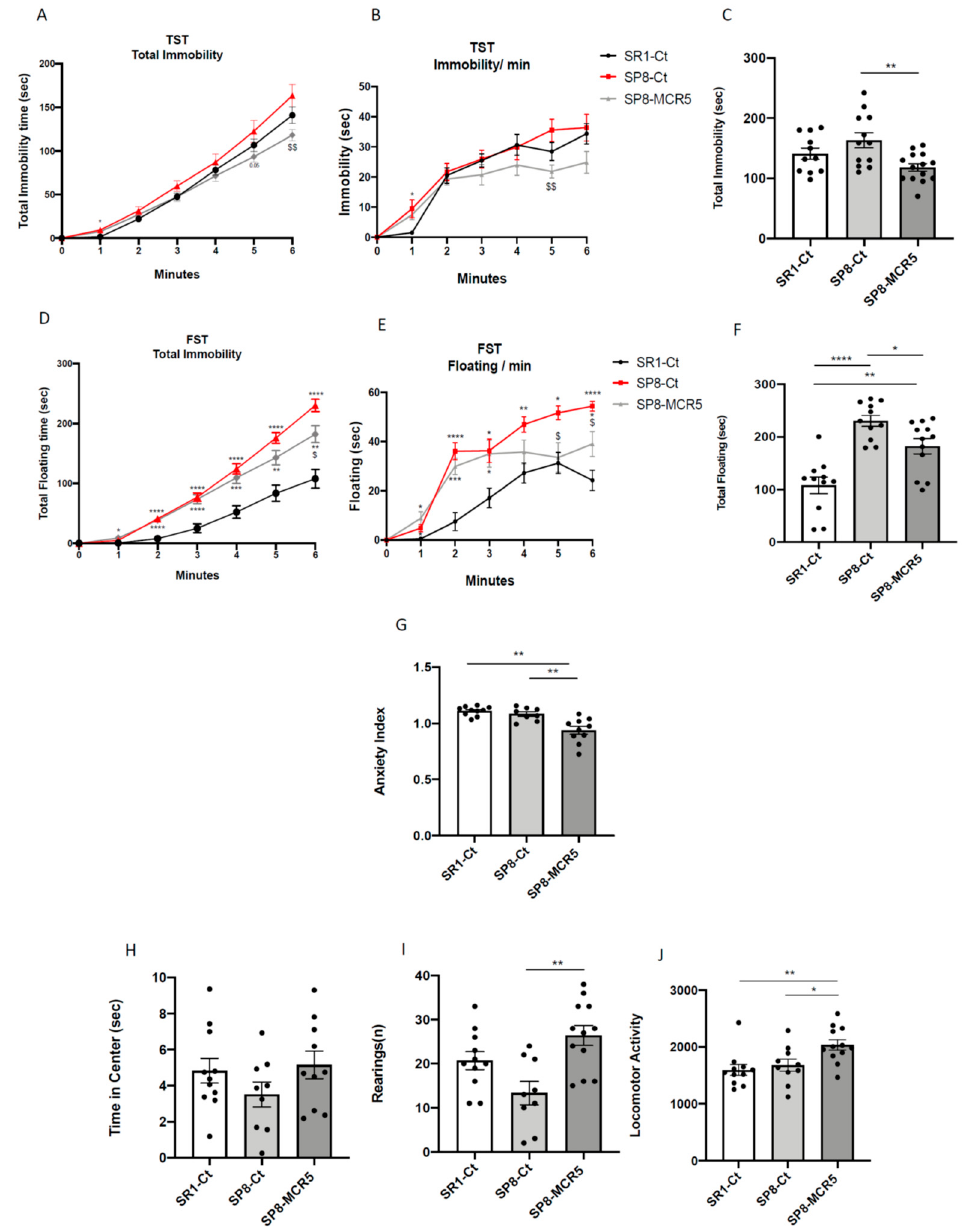
Figure 3. Results of Tail suspension test (TST), Forced swimming test (FST), Elevated plus maze (EPM), and Open field test (OFT) in male mice at 10-month-old SR1 and SP8 Ct mice groups and SP8 treated with I 2 -IR ligand MCR5 (5 mg / Kg) mice group. For TST: total immobility curve ( A ), immobility / min ( B ), and total immobility ( C ). For FST: total immobility curve ( D ), floating / min ( E ), and total floating ( F ). For EPM: anxiety index ( G ). For OFT: time in the centre ( H ), rearings ( I ), and locomotor activity ( J ). Values represented are mean ± Standard error of the mean (SEM); n = 36 (SR1-Ct n = 11; SP8-Ct n = 11; SP8-MCR5 n = 14). * p < 0.05; ** p < 0.01; *** p < 0.001; **** p < 0.0001. Behavioural and emotional changes after MCR5 treatment were evaluated by EPM and